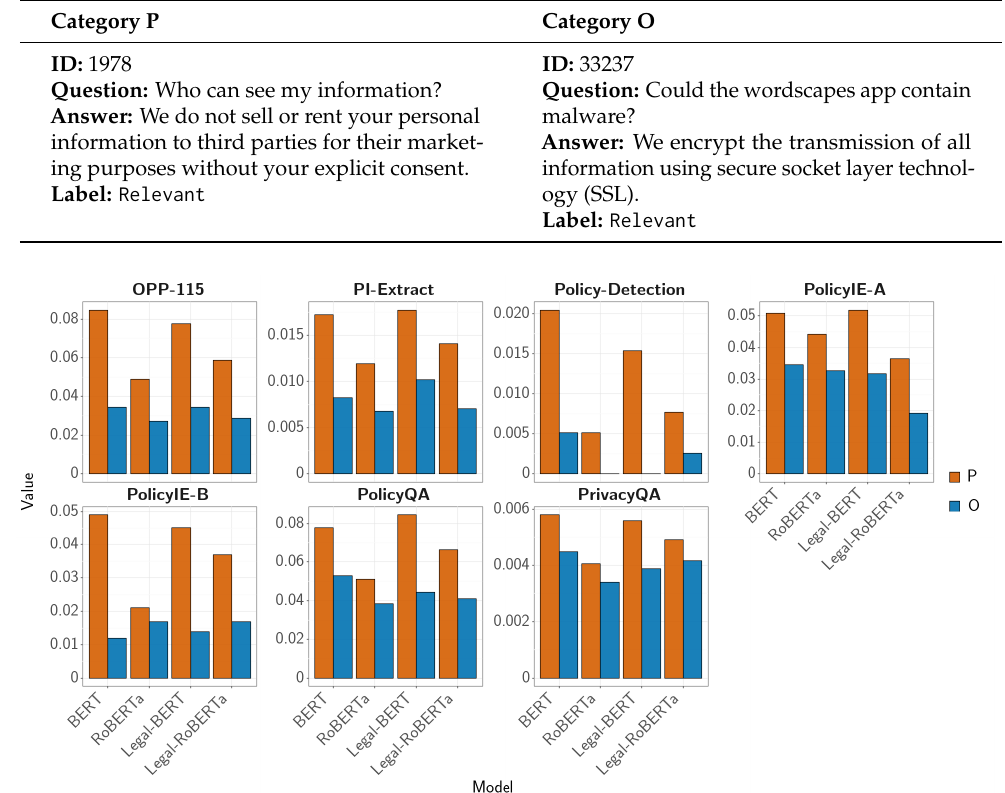
Figure 4. Model–pair agreement analysis of PrivBERT against other models over all PrivacyGLUE tasks; bars represent proportions of examples per model–pair and task which fell into categories P and O; all models on the x-axis are compared against